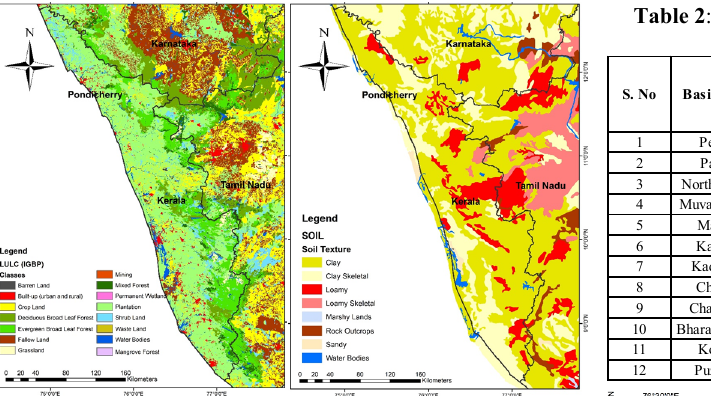
Figure 3. a) LULC map and b) Soil texture map of Kerala and surrounding areas.